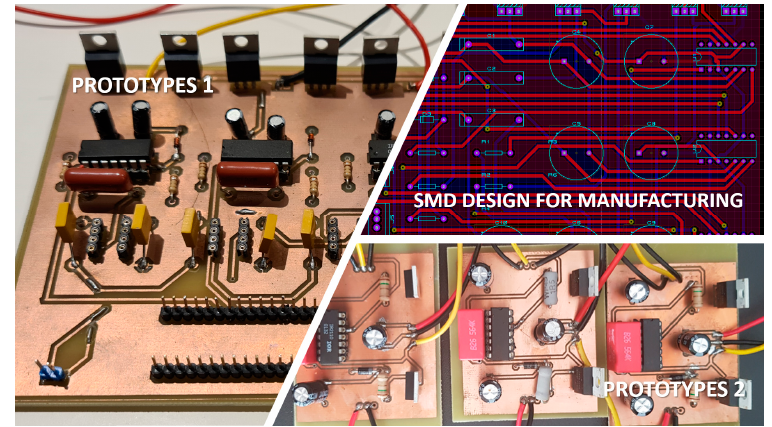
Figure 17. PCB test prototypes.